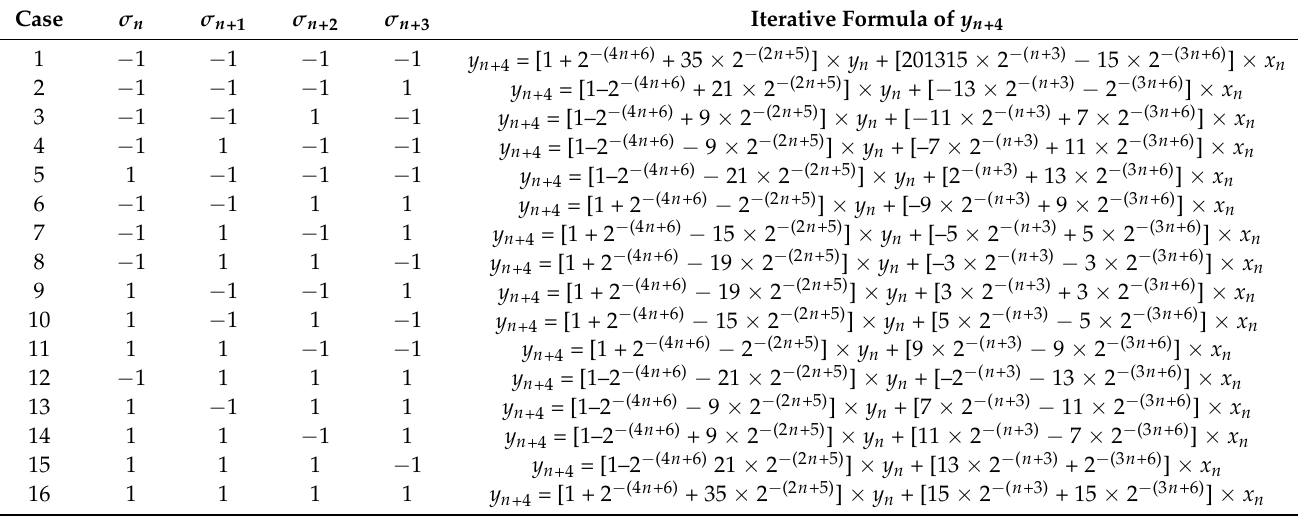
Table 2 details the corresponding iterative formulae of z n +4 when { σ n , σ n +1 , σ n +2 , σ n +3 } ranges from { − 1, − 1, − 1, − 1} to {1, 1, 1,